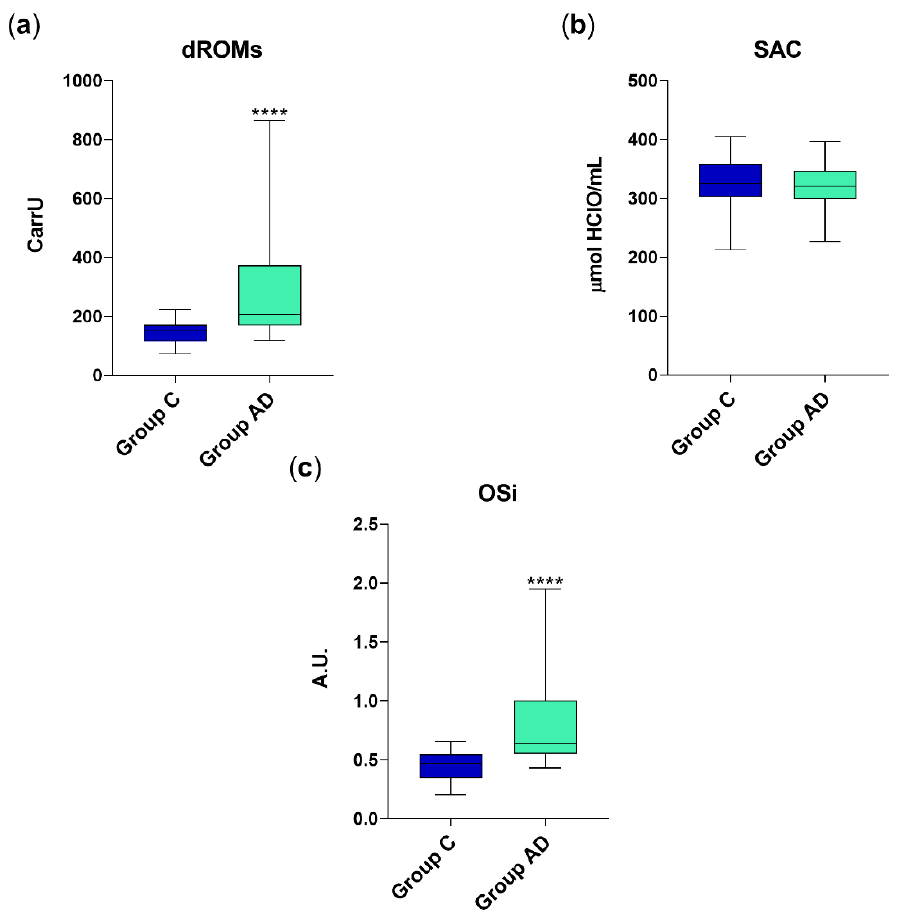
Figure 1. dROM ( a ), SAC ( b ) and OSi values ( c ) in group C (healthy animals, n = 30) and AD (diarrhetic dogs, n = 45). Data are represented as boxplot showing median and interquartile range and analyzed by Mann–Whitney test. Statistical differences with respect to group C are reported (**** p < 0.0001). A.U. = arbitrary units.